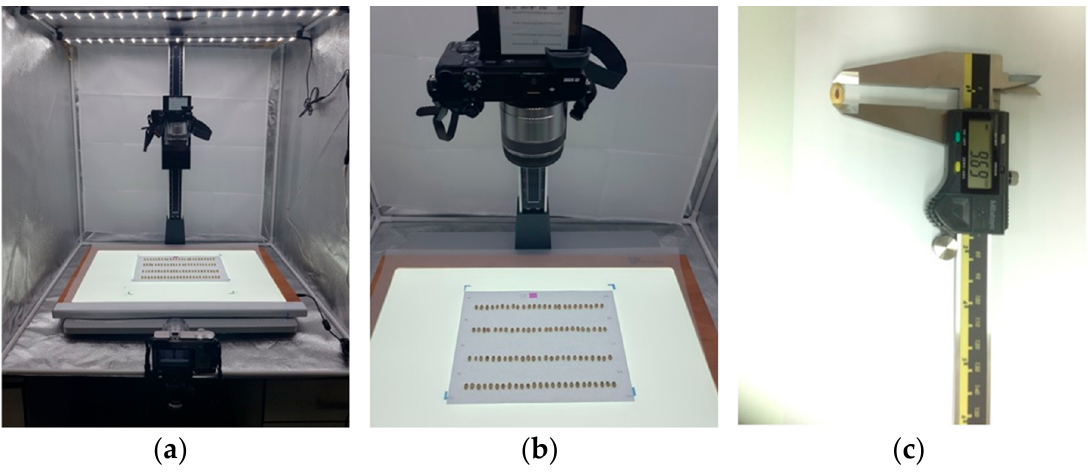
Figure 2. Device of soybean seed phenotype analysis used in high-throughput method. ( a ) top and side camera; ( b ) arrangement of soybean seeds; ( c ) actual measurement using Vernier calipers.